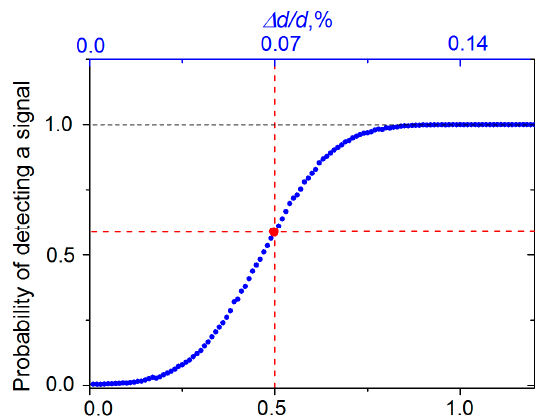
Figure 10. The probability of successful signal detection as a function of signal-to-noise ratio ( S / N ). On the top horizontal axis, the change of the corresponding interparticle distance for the polystyrene sample without Al is shown. The red lines correspond to the value of S / N = 0.5 and P ( S / N ) = 0.6.